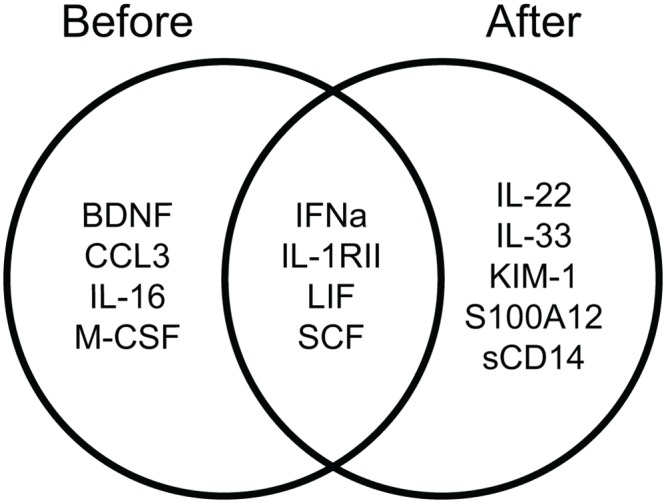
Overlap of serum markers correlating with outcome of islet transplantation.Venn diagram showing serum markers that predict or correlate with clinical outcome (good or poor graft function) 1 year after islet transplantation.